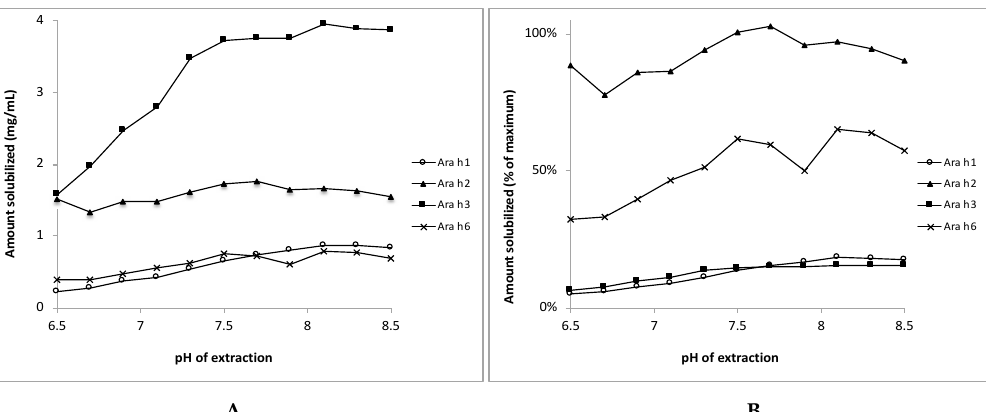
Figure 5. Release of individual peanut allergens from their matrix of light roasted peanut flour dissolved at various pHs mimicking saliva. Panel A : Protein concentrations in the supernatants, in mg/mL. Panel B : Protein concentrations in the supernatants expressed as percentage of the theoretical maximum value. Mean values of two experiments are shown (SDs were typically between 0 and 8% of the mean (except in one case were the SD was 13% of the values; for Ara h6 at pH = 7.9). SDs are not shown here to improve readability.